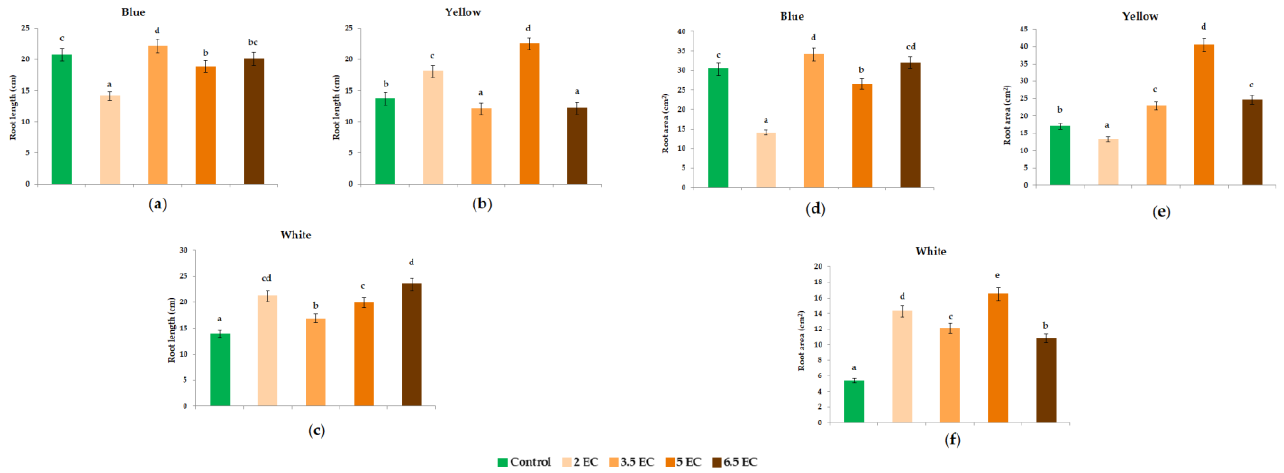
Figure 4. Effect of nutrient solution electrical conductivity levels 1 (control), 2, 3.5, 5, and 6.5 mS cm − 1 EC on root length (cm) ( a – c ) and root area (cm 2 ) ( d – f ) of selected Viola × wittrockiana seedlings. Bars represent the means ± SE ( n = 40). Different letters indicate significant differences between treatments ( p < 0.05).